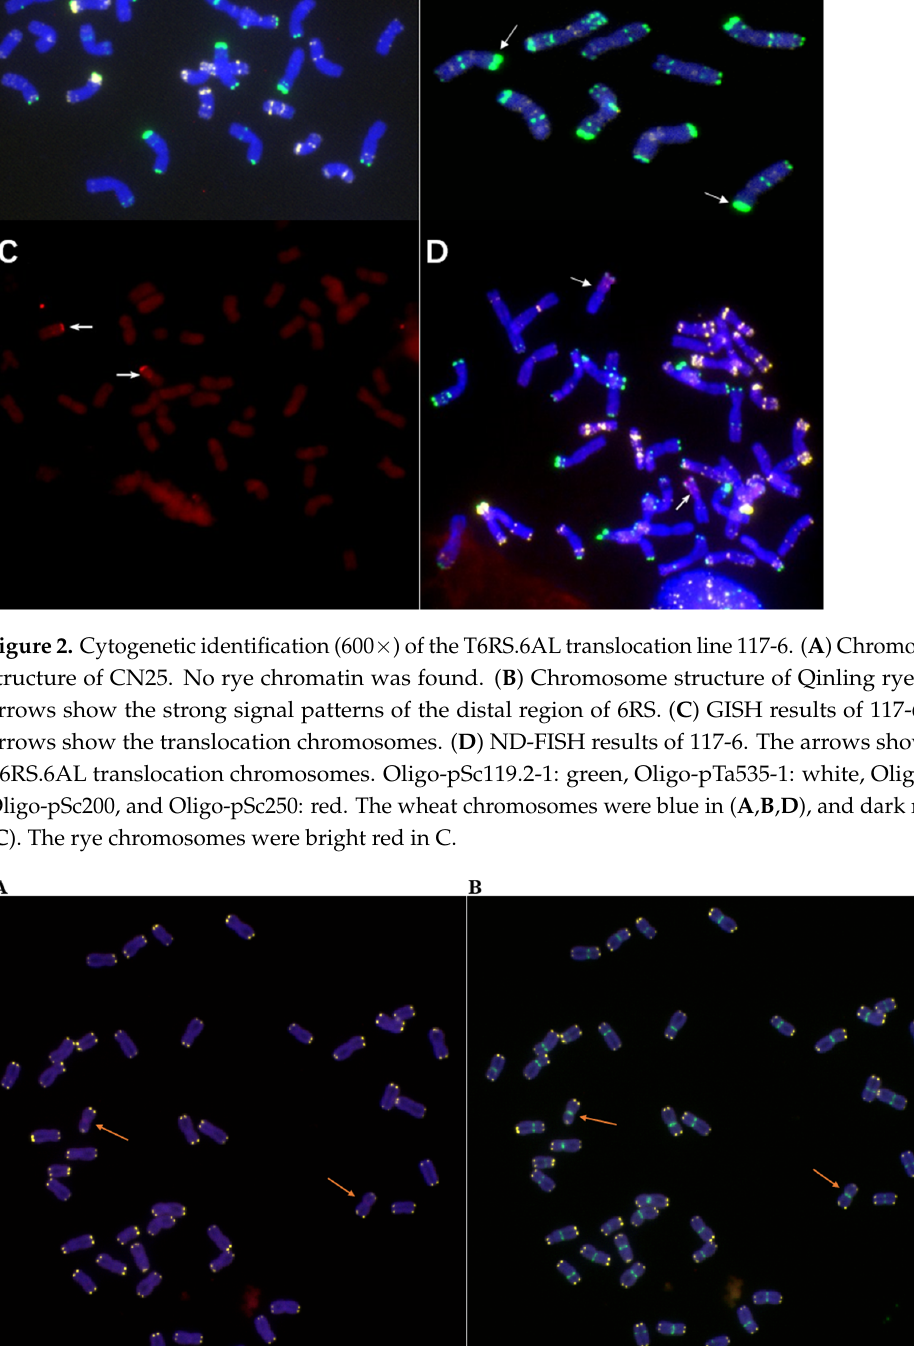
Figure 3. Cytogenetic identification (600x) of the centromere and telomere of T6RS.6AL transloca- tion line 117-6. ( A ) The signals of Oligo-PAWRC.1 (red), and Oligo-Telo (white). ( B ) The signals of Oligo-CCS1 (green), and Oligo-Telo (white). The signal patterns were derived from one cell. The wheat chromosomes were blue. The arrows showed the T6RS.6AL translocation chromosomes